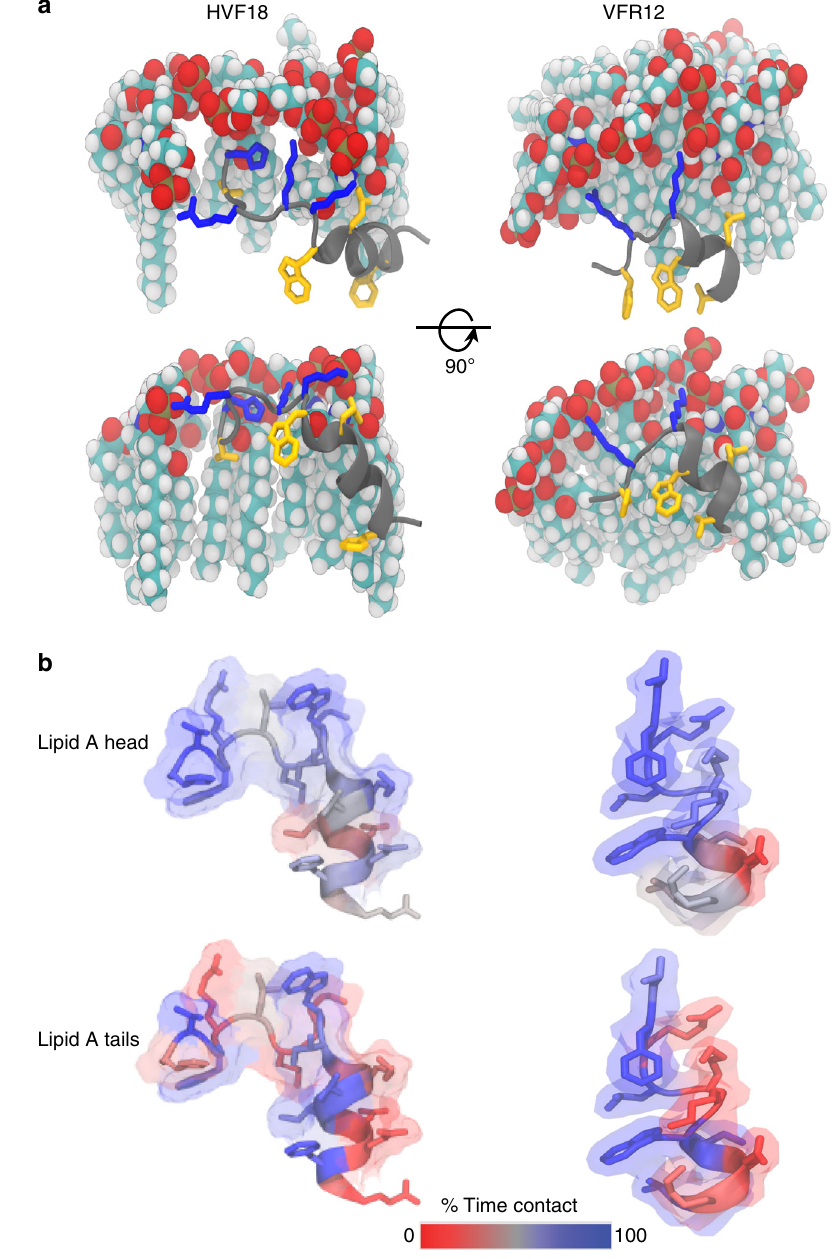
Fig. 5 Molecular dynamics (MD) simulations of thrombin C-terminal peptides with lipid A aggregates. a All-atom (AA) MD simulations of HVF18 and VFR12 showing side chains of hydrophilic (blue) and hydrophobic (yellow) residues in contact with the headgroup and lipid A acyl tail. b HVF18 and VFR12 NMR structures highlighting the side chain residue contact differences with the LPS head group and acyl chain obtained from coarse grained (CG) molecular dynamics